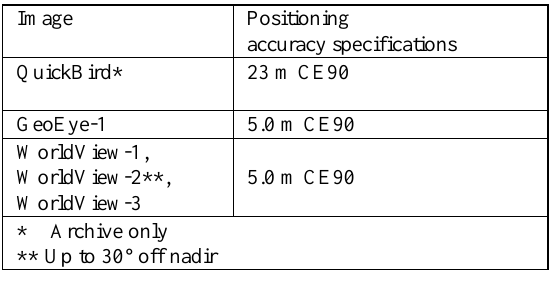
Table 2. Positioning characteristics of utilized platforms (Digitalglobe,